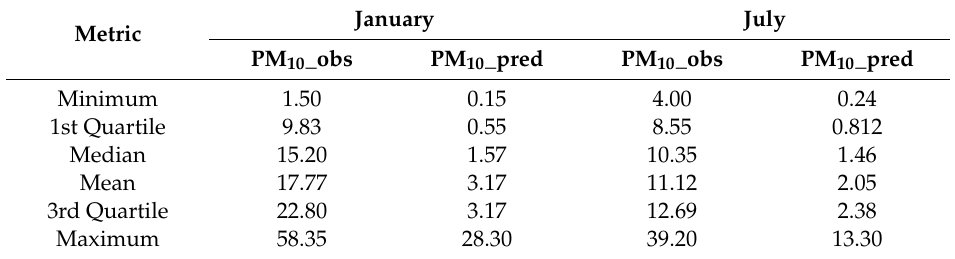
Table 8. Summary of the observed and predicted PM 10 concentrations ( µ g / m 3 ) in the months of January and July 2017 at Devonshire Green monitoring stations.